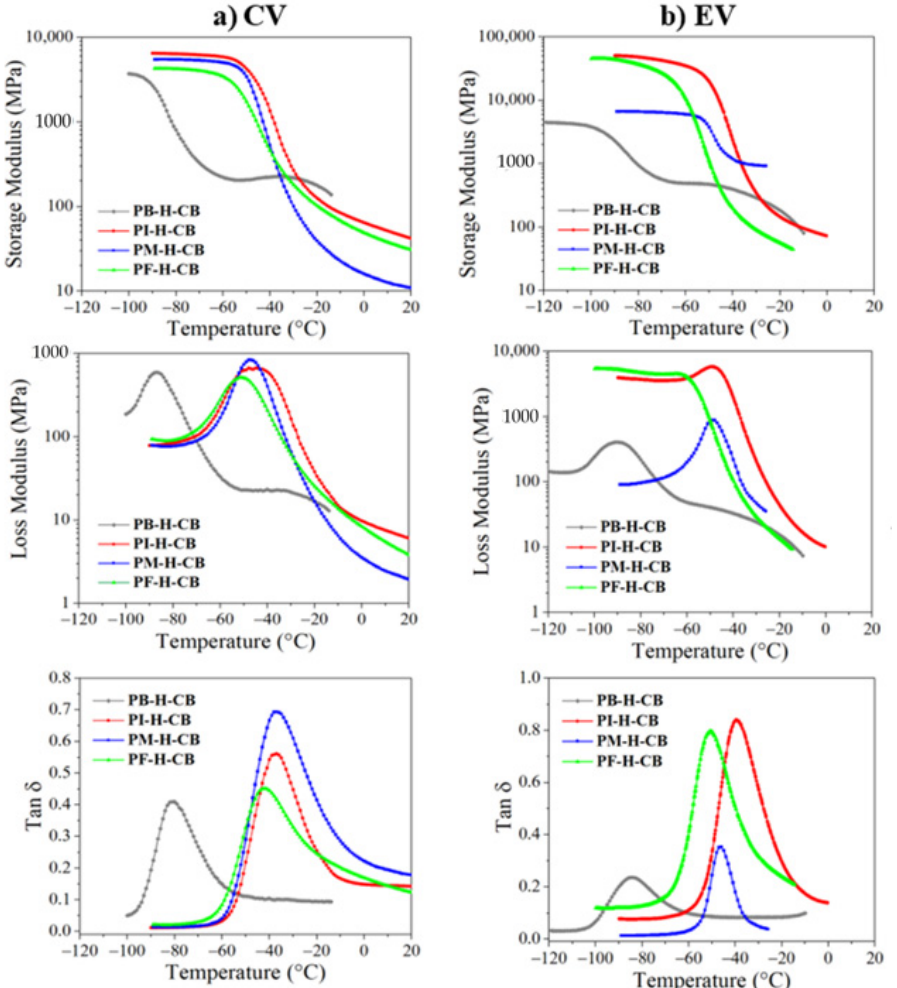
Figure 10. Storage modulus, loss modulus, and Tan δ of the crosslinked reinforced materials through the system CV ( a ) and EV ( b ) by DMA.